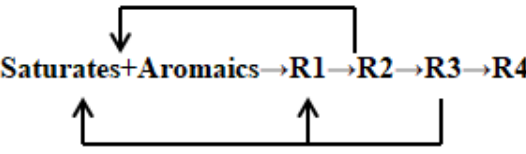
Table 3. - Physical and chemical properties of the initial